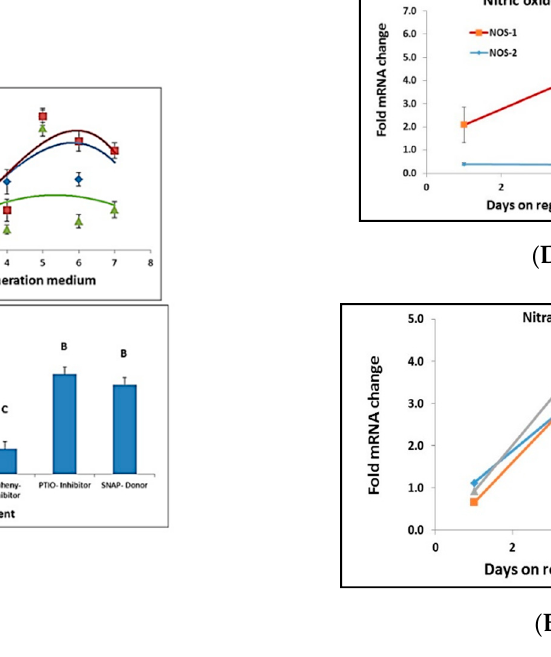
Figure 5. NO has a role in shoot regeneration. ( A ) NO staining at the border of leaf segments placed on regeneration medium in the presence of NO inhibitor (Reg+I), NO donor (Reg+D) and control (Reg). ( B ) Stain intensity per cell at the borders of leaf segments during the induction period of shoot induction. NO inhibitor (Regd), NO donor (Regm), and control (Reg). ( C ) Effect of NO donors (S-Nitroso-N-acetyl-DL-penicillamine; Molsidomine), NO scavenger (PTIO), and NO synthesis inhibitor (Diphenyleneiodonium) on shoot regeneration. Different letters (A, B, C) define statistically different results, p(f) was 7.65 × 10 − 35 using Tukey test. ( D ) Transcript level of Nitric Oxide Synthase1 increases during shoot induction while transcript level of Nitric Oxide Synthase2 is unchanged. The data presented are from the Differential Gene Expression experiment. ( E ) Transcript level of all Nitrate reductase genes increase during incubation on Reg medium. The data presented are from the Differential Gene Expression experiment. Reg = regeneration medium; regm = regeneration medium with added Molsidomine; regd = regeneration medium with added Diphenyleneiodonium. NR = nitrate reductase; NOS = nitric oxide synthase. Error bars indicated standard error of 50 cells in ( B ); 20 segment in 3 replicated in ( C ); and 3 biological replicates in ( D , E ).